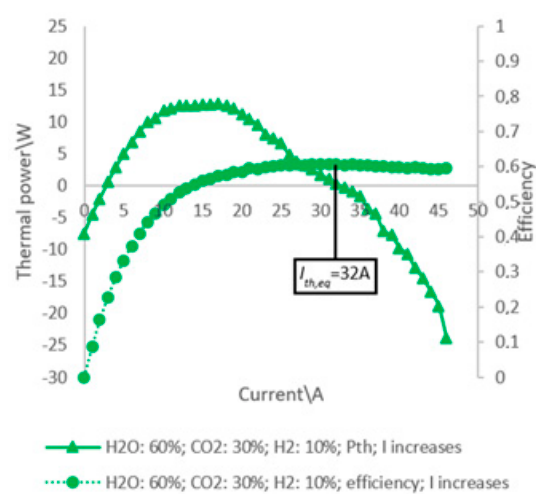
Figure 10. Trends of total thermal power and net production efficiency for the SOE stack fed by the steam-CO 2 mixture and by air at varying the stack current. steam-CO 2 mixture and by air at varying the stack current.